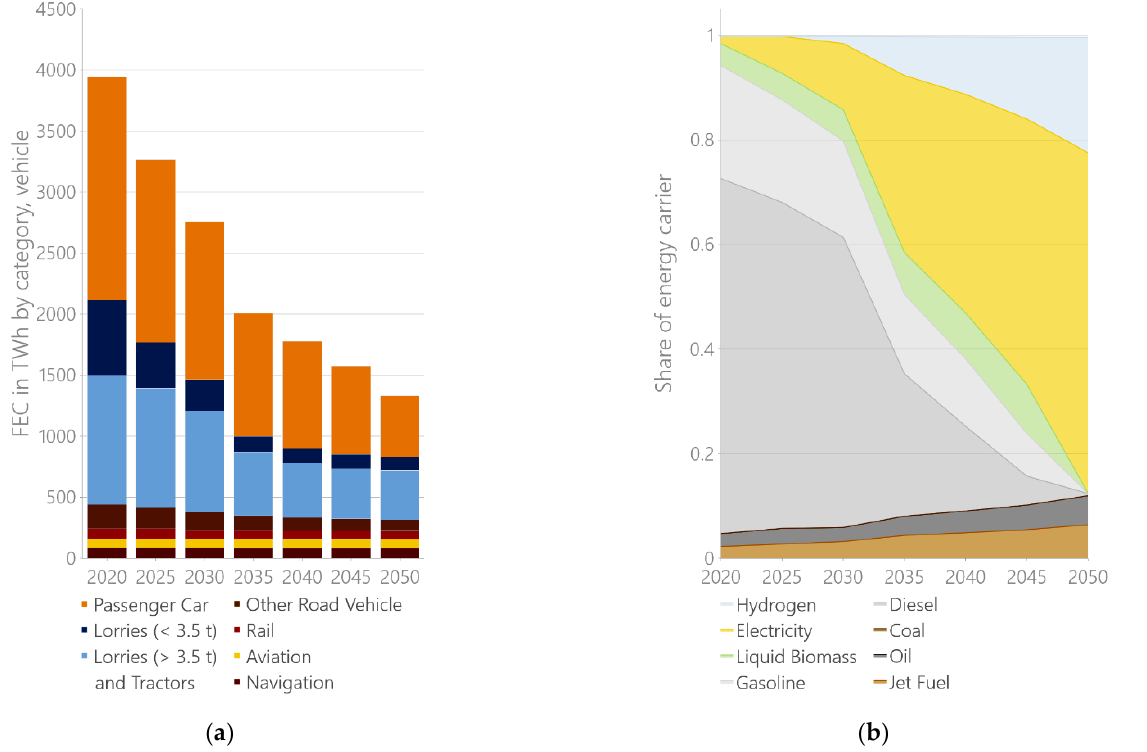
Figure 6. Share of vehicle category ( a ) and share of energy carriers ( b ) in the FEC in the transport